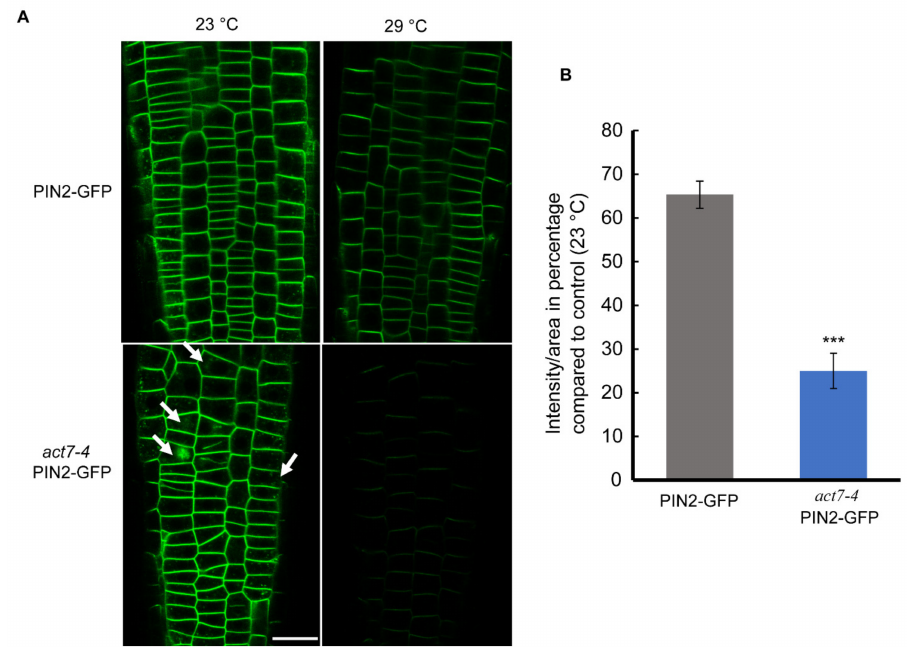
intracellular agglomeration of PIN1 ( B ) Quantification of GFP fluorescence intensity from ( A ). The images were captured using the same confocal setting. Vertical bars represent mean ± SE of the 15–20 seedlings from at least three independent experiments. Asterisks represent the statistical significance between the means of the percentage Col-0 and mutant judged by the Student’s t - test (*** p < 0.001). Five-day-old light grown seedlings were transferred to new agar plates and subjected to high-temperature treatment (29 ◦ C) for 72 h before imaged with confocal microscopy using the same confocal settings and are representative of 15–20 seedlings obtained from three independent experiments.